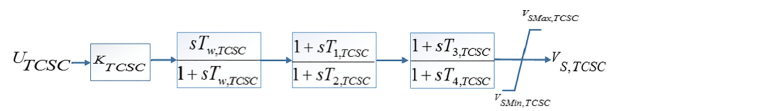
Fig 4. Block diagram of the TCSC POD controller.